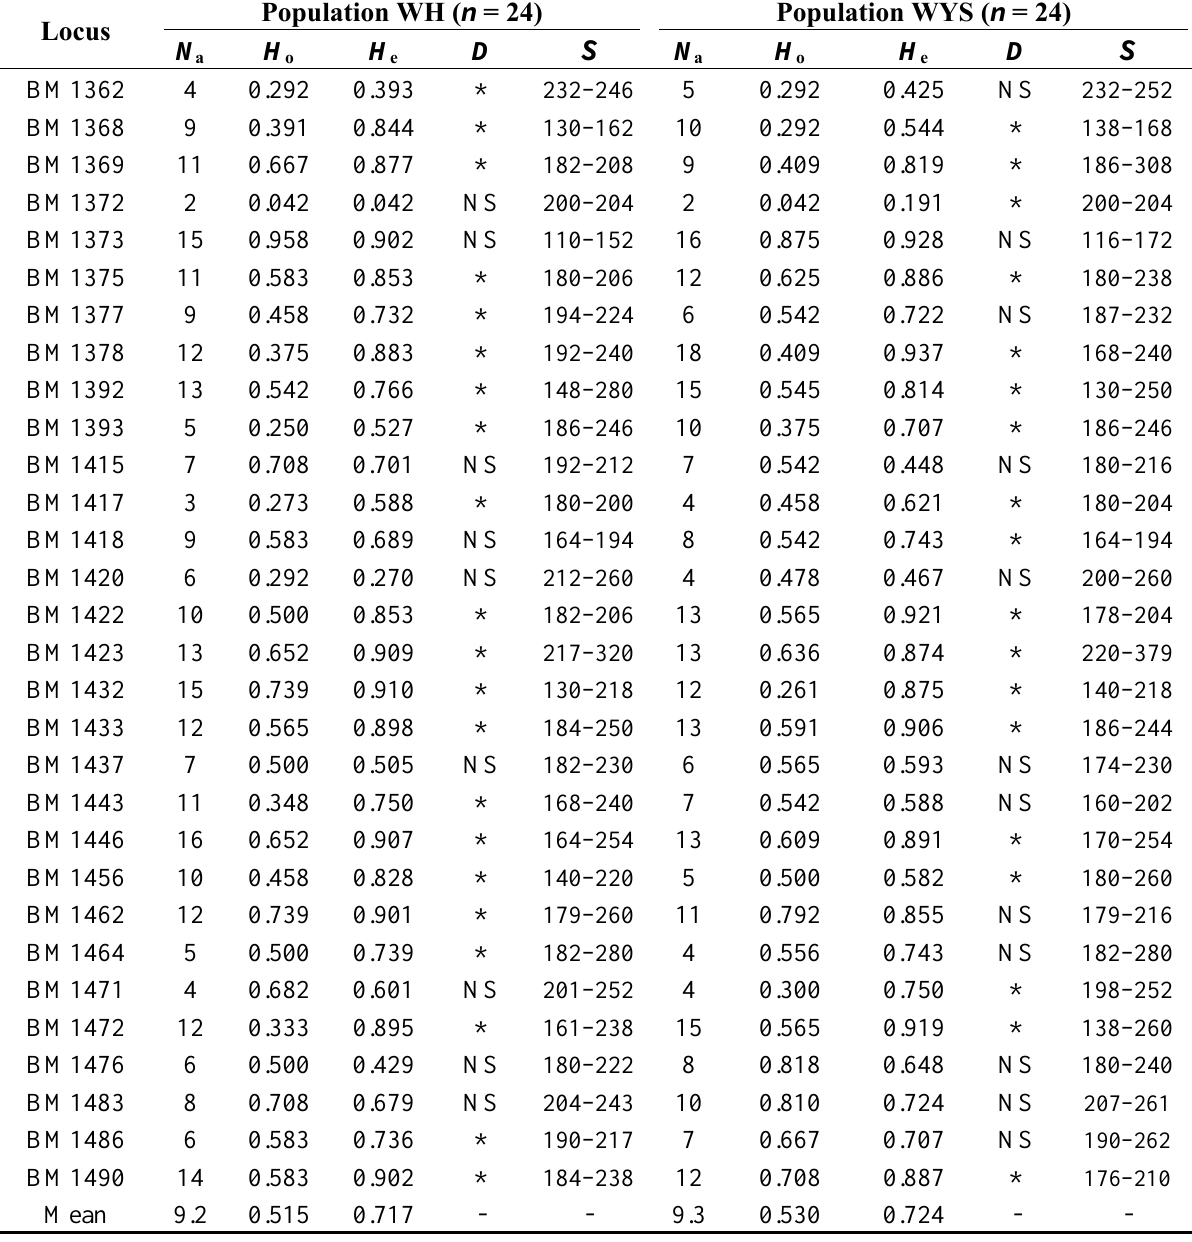
Table 2. Diversity estimation in two populations of Nilaparvata